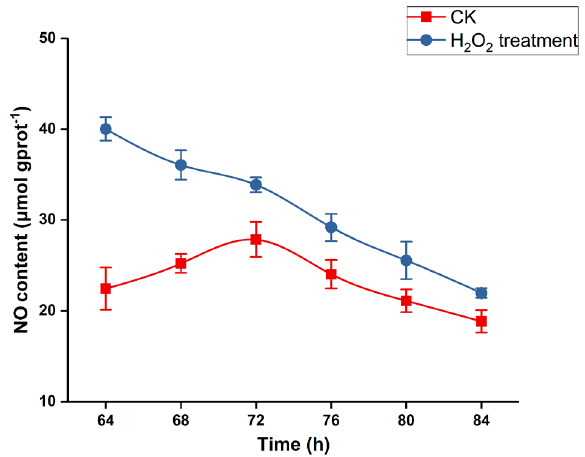
Figure 2. Effects of exogenous hydrogen peroxide on the content of intracellular nitric oxide. Values are the means of five independent experiments ± SE.